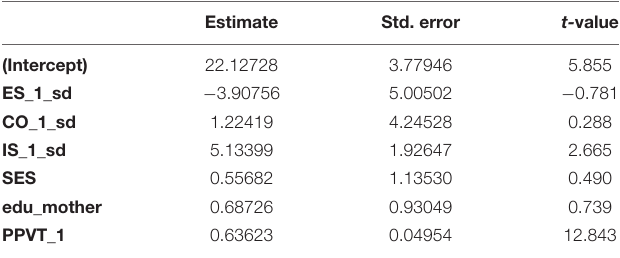
TABLE 4 | A multilevel regression